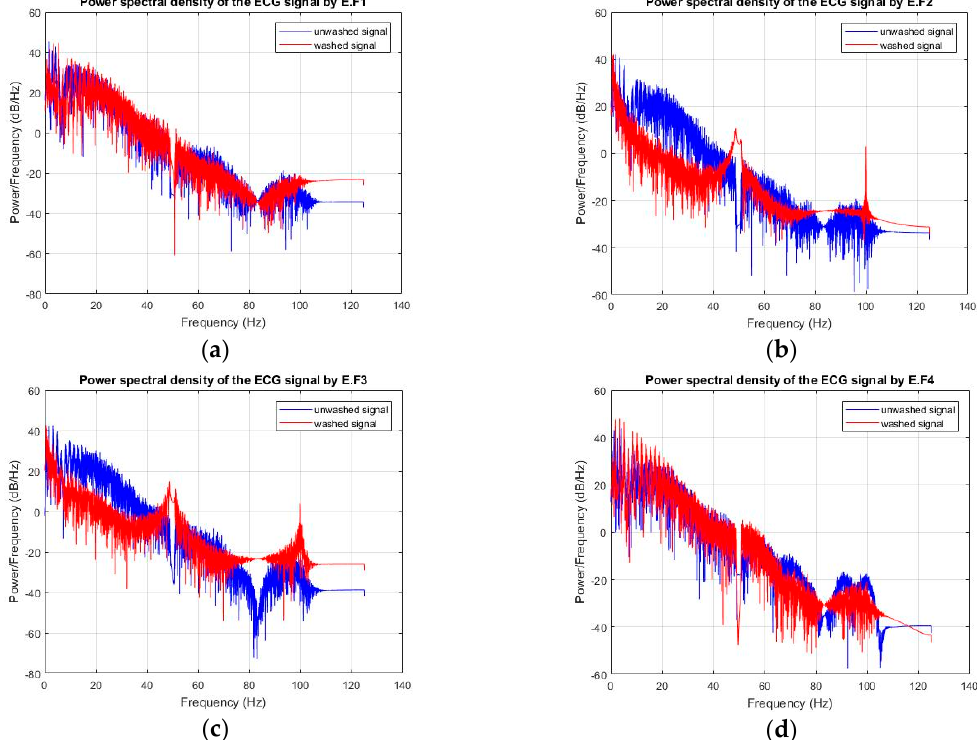
Figure 7. Power spectrum density (express wash), ( a ) F1 ( b ) F2 ( c ) F3 ( d ) F4.